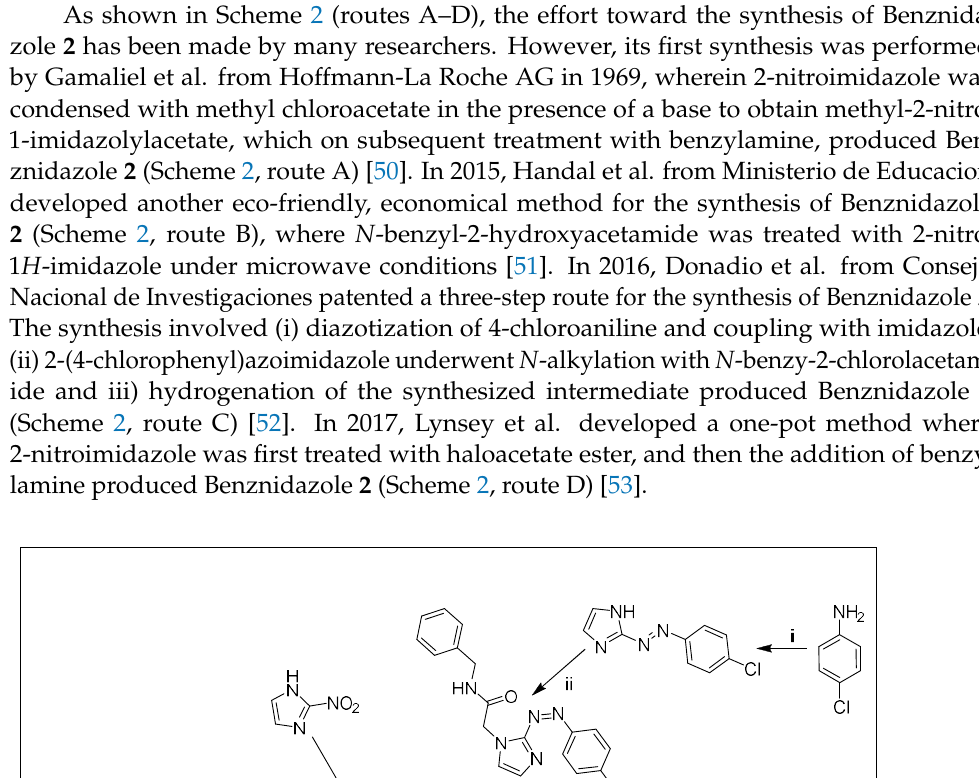
Figure 5. Activity profile of Benznidazole 2